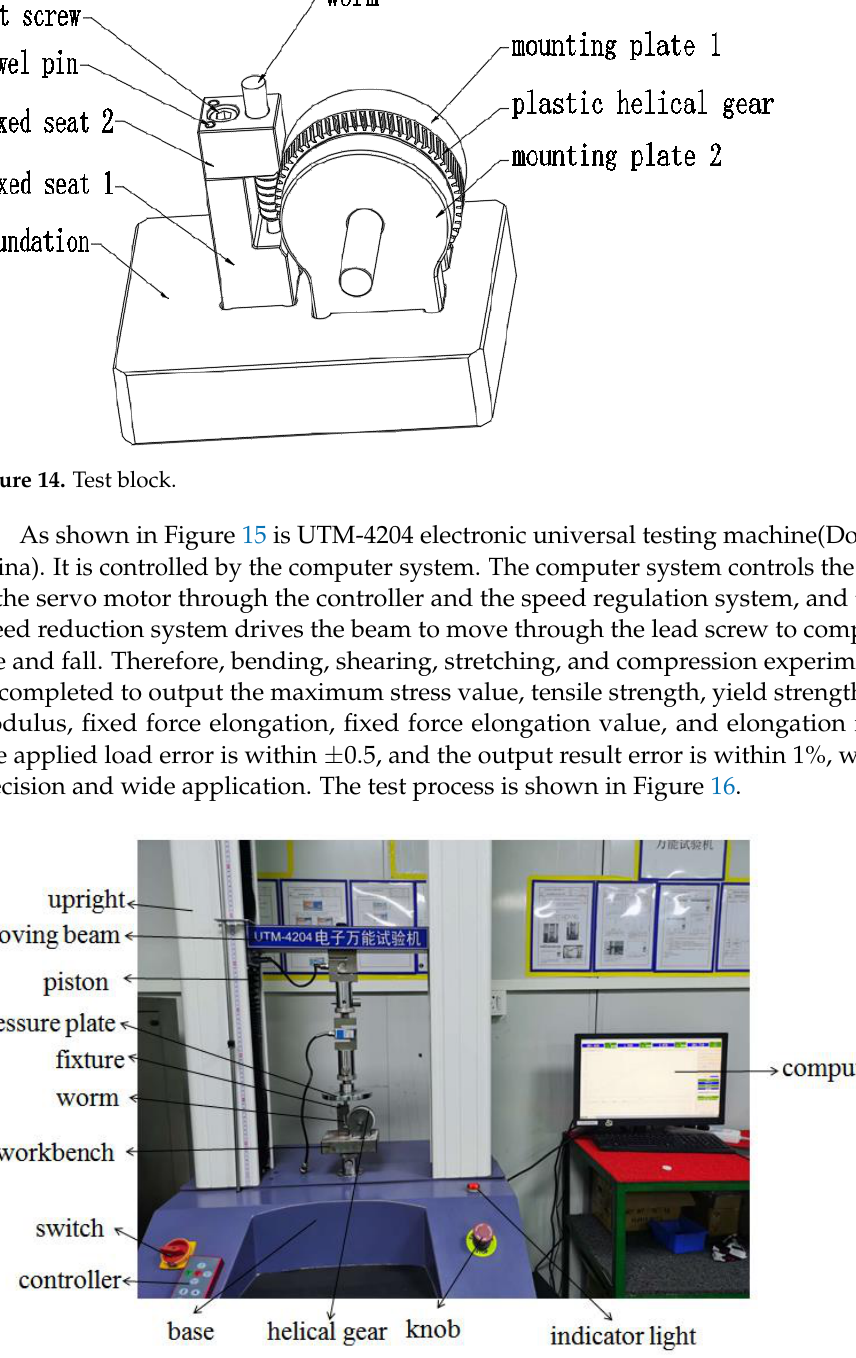
Figure 16. Test process. 7.2. Parameter for Worm and Plastic Helical Gear We make some sample of worm and plastic helical gear, engineering drawing as (Fig- ure 17 and Figure 18) , according to parameter and some dimension. Then we fixed on gear box.